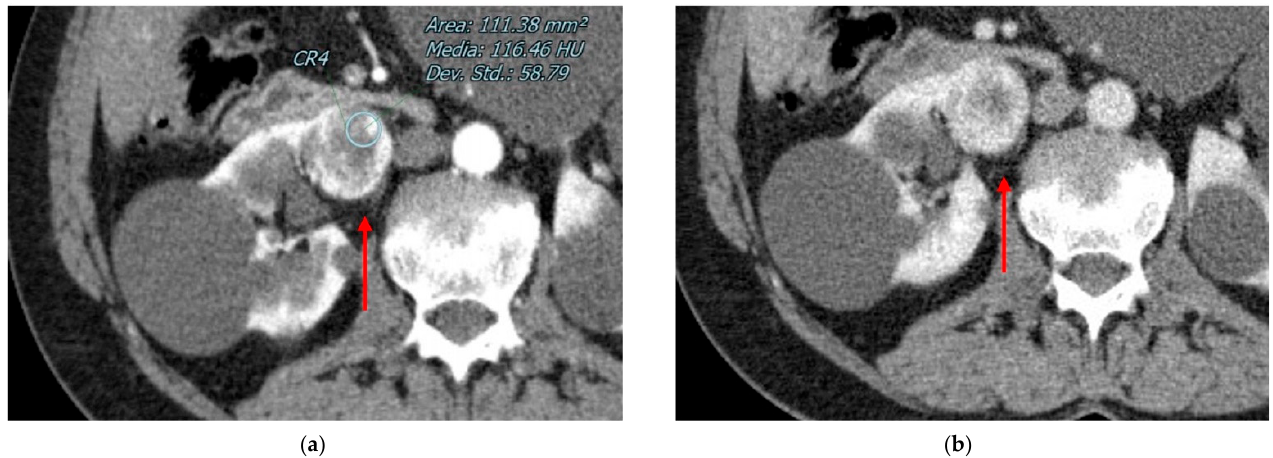
Figure 2. Abdominal CECT of 66 year-old male patient with a 16 mm nodular lesion in his right kidney. After the administration of contrast, the small lesion enhanced homogeneously, showing the peculiar hypervascular pattern ( a ) and revealing a central scar ( b ). These features are suitable for oncocytoma. Differentiation of oncocytoma from RCC is considered difficult. A central stellate